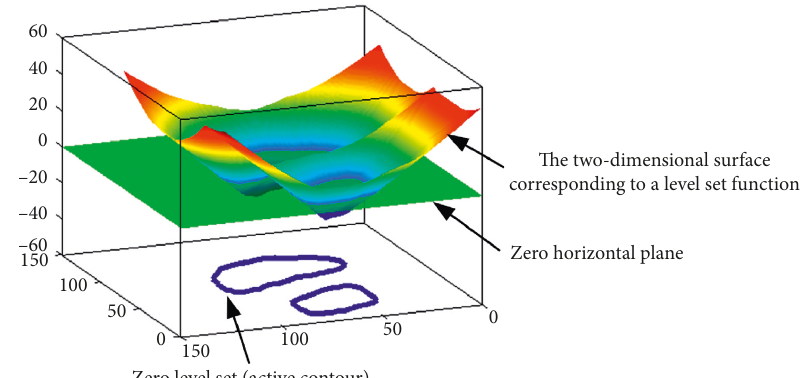
Figure 1: Level set function and its corresponding zero level set.